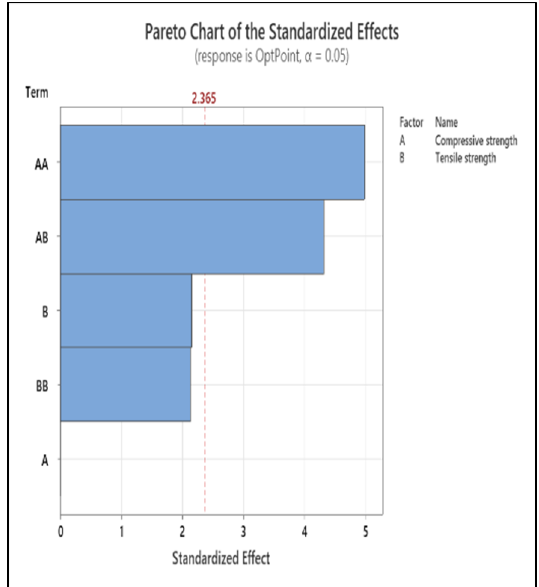
Figure 11. Pareto chart of optimal points for compressive (A) and tensile (B) strength.